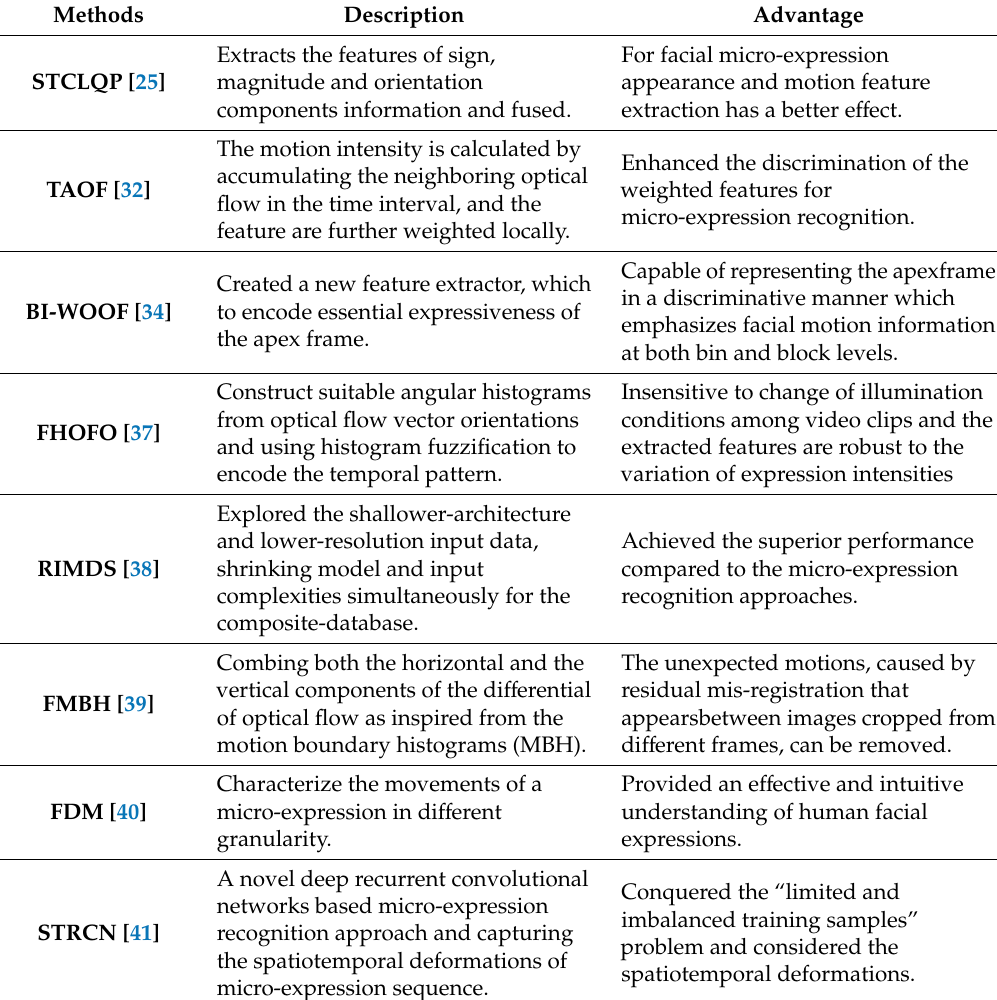
Table 1. Analysis of the state-of-the-art-review for micro-expression